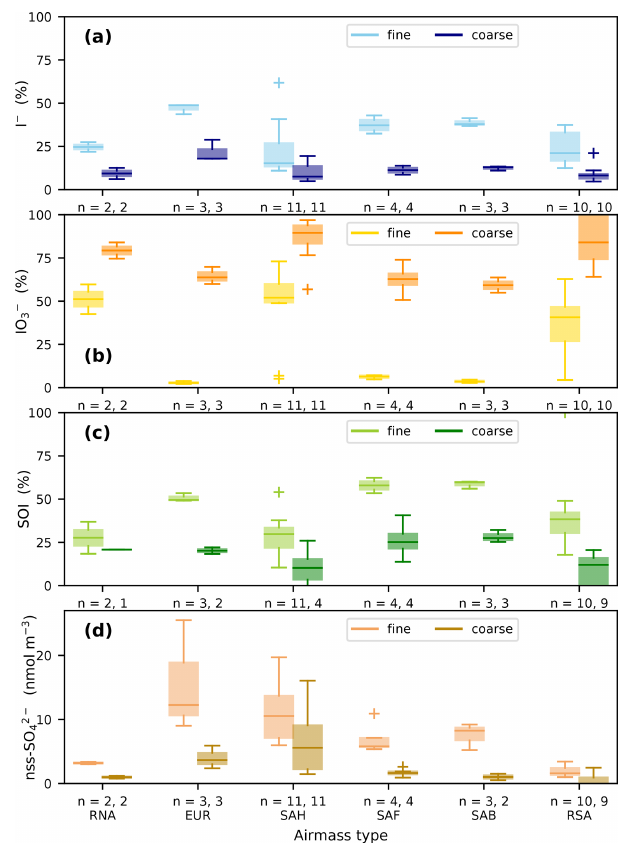
Figure 4. Proportions of (a) I − , (b) IO − , and (c) SOI (expressed 3 as percentage of TSI) and (d) the concentrations of nss-SO 2 − in 4 fine ( < 1µm) and coarse ( > 1µm) aerosols in the different air mass types encountered during AMT21. The number of samples in fine and coarse fractions respectively for each group ( n ) is also shown. In some cases, unreliable results for SOI and nss-SO 2 − in the coarse 4 mode were excluded, as described in the text. Boxes show the inter- quartile range of the data, with horizontal lines representing the me- dian. Whiskers show the range of the data, except where outliers more than 1.5 times the inter-quartile range beyond each quartile are present